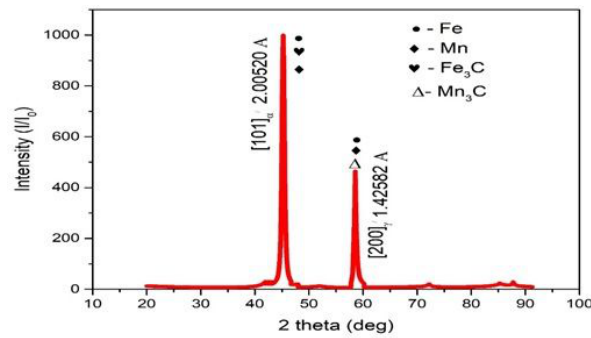
Figure 15: XRD Patterns for AHSS-DP800